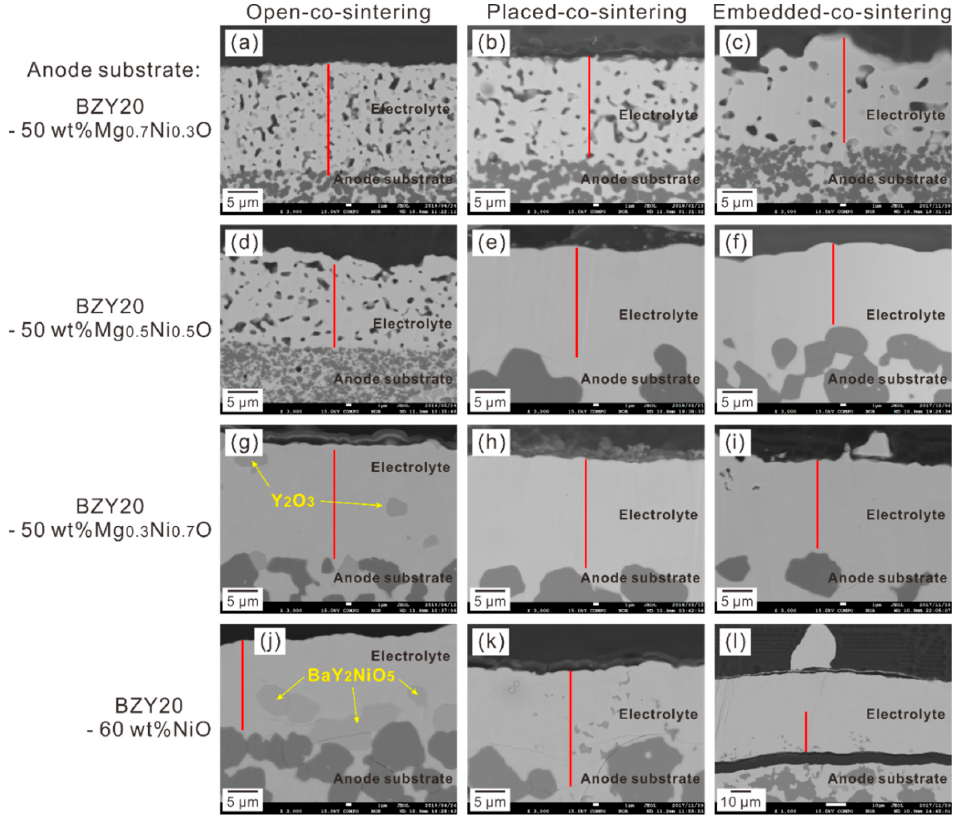
Figure 2. Back-scattering electron images of the cross-section area of the half cells with the BZY20-50 wt % Mg 0.7 Ni 0.3 O anode substrate prepared with the methods of ( a ) open-co-sintering, ( b ) placed-co-sintering, ( c ) embedded-co-sintering, and the BZY20-50 wt% Mg 0.5 Ni 0.5 O anode substrate prepared with the methods of ( d ) open-co-sintering, ( e ) placed-co-sintering, ( f ) embedded-co-sintering, and the BZY20-50 wt% Mg 0.3 Ni 0.7 O anode substrate prepared with the methods of ( g ) open-co-sintering, ( h ) placed-co-sintering, ( i ) embedded-co-sintering, and the BZY20-60 wt % NiO anode substrate prepared with the methods of ( j ) open-co-sintering, ( k ) placed-co-sintering, ( l ) embedded-co-sintering. All the half cells were co-sintered at 1600 °C in oxygen for 10 h with the methods shown in Figure 1. The red line indicates the position for EPMA-WDS line analysis. It should be noted that the scale bar of ( l ) is larger than those of the other images.